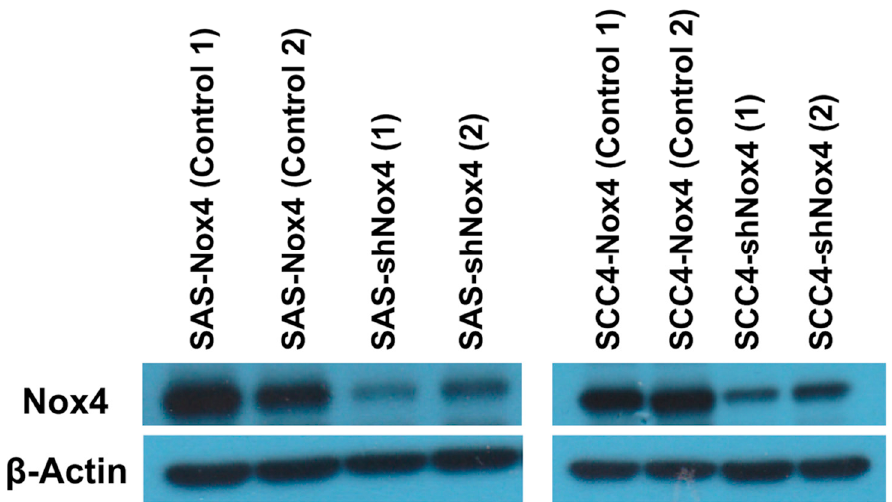
Figure 1. Western blotting analysis of Nox4 expression and knockdown of Nox4 in two oral tongue squamous cell carcinoma cell lines, SAS and SCC4.